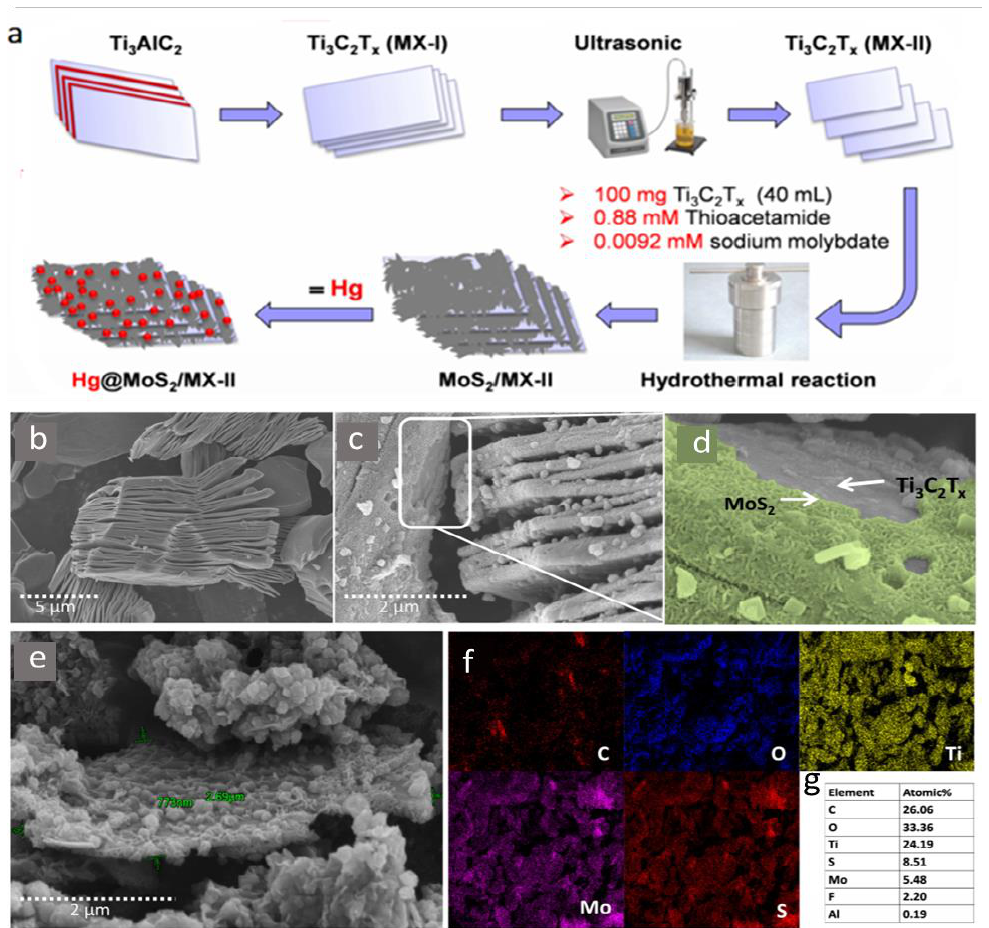
Figure 11. ( a ) Synthesis of MoS 2 /MX-II nanocomposite. SEM images of ( b ) Ti 3 C 2 T x , ( c , d ) MoS 2 /MX-I, and ( e ) MoS 2 /MX-II. ( f ) Elemental mapping of elements in MoS 2 /MX-II. ( g ) Elemental content (at %)